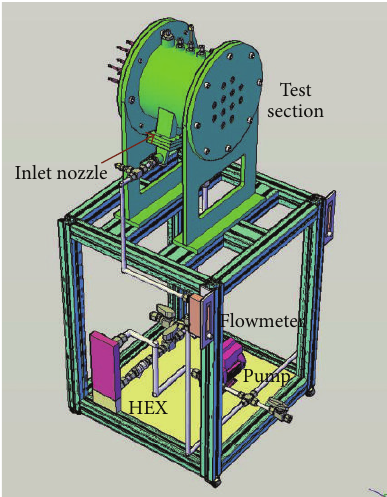
Figure 1: 1/40 scaled-down test facility for CANDU-6 moderator